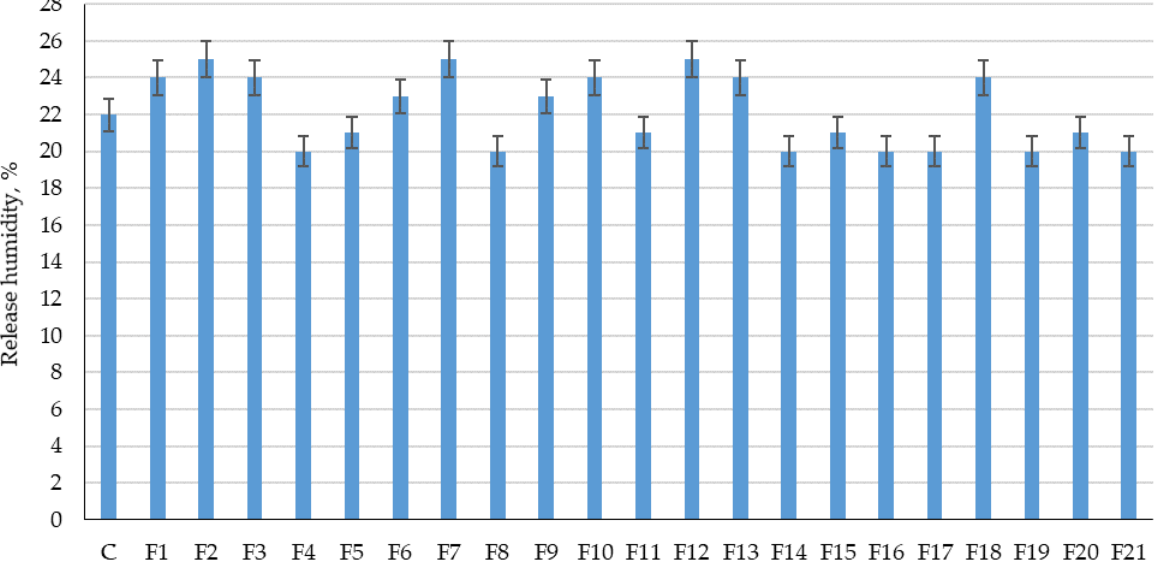
Figure 12. Results of experimental studies of the release moisture content of fiber foam concrete samples at various dosages of microsilica introduced instead of a part of the binder and dosages of polypropylene fiber of 0%, 1%, 2%, 3%.